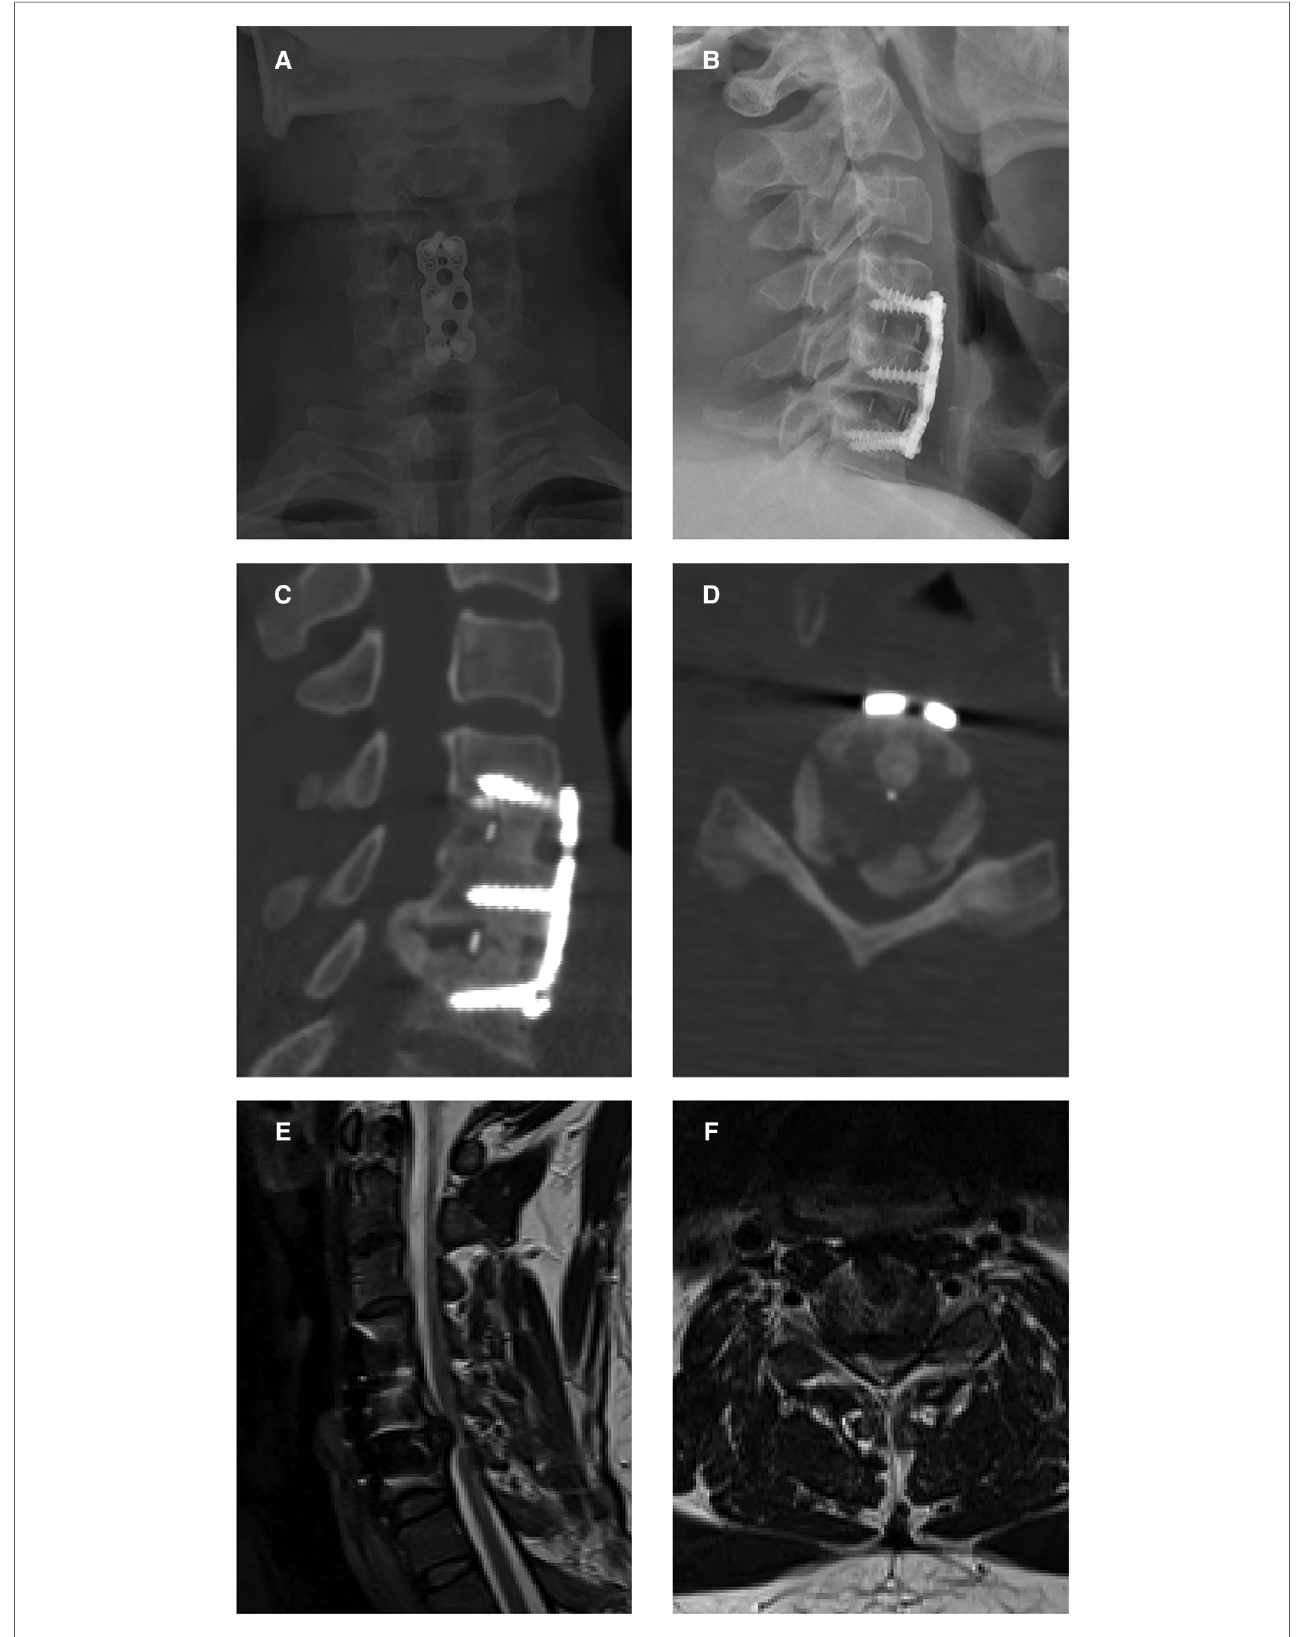
FIGURE 2 Preoperative images before open-door laminoplasty. ( A,B ) Preoperative x-ray images showing a large posterior cervical osteophyte at the level of C5/6. ( C ) A preoperative sagittal CT image showing a large heterotopic bone achieved from the posterior side of the C4 inferior end plate to the posterior side of the C5 superior end plate. ( D ) A transverse CT image revealing evident cervical stenosis and anterior spinal cord compression due to ossi fi cation. ( E,F ) Preoperative MR images showing the narrow space of the spinal canal and a T2-weighted hyperintense intramedullary signal at the C5/6